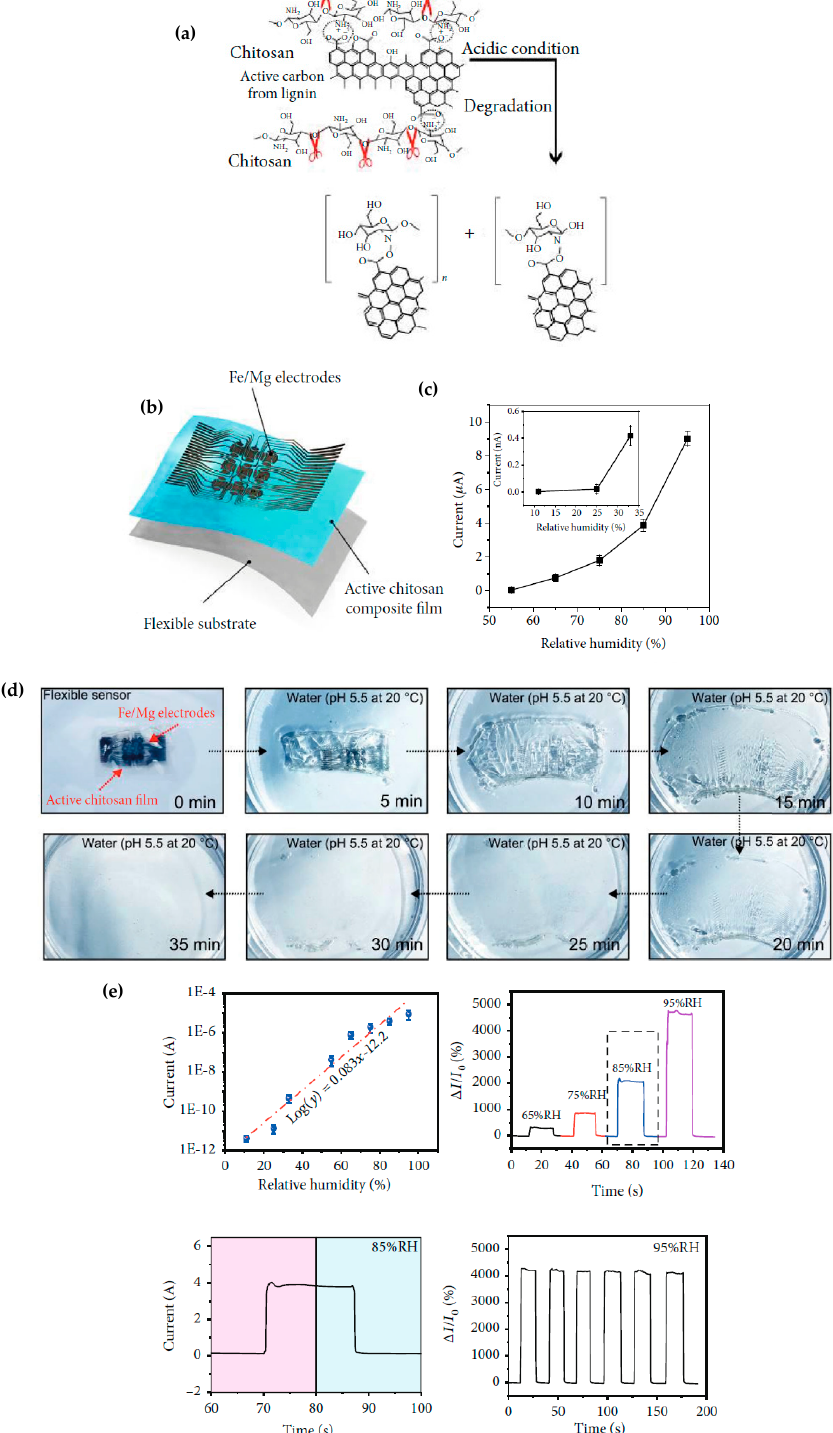
Figure 39. ( a ) Mechanism for the preparation of the biodegradable substrate. ( b ) Illustration of the flexible device. ( c ) Changes in current as a function of humidity. ( d ) Pictures of the progressive degradation upon insertion into water (pH 5.5) at room temperature. ( e ) Humidity-sensing properties: current under different RH (voltage bias of 1 V); Relative current changes under increasing %RH; Dynamic current change under 85%RH for 20s; Relative current changes upon repetitive exposure to 95%RH. Adapted from [161] with permission. Copyright © 2020 L. Wang et al. Exclusive Licensee License (CC BY